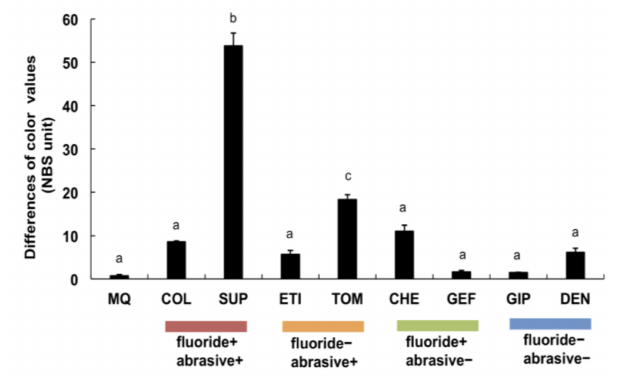
Figure 3. Influence of brushing with toothpastes or MQ on titanium color. The color values represent the variations with the values of control sample. Independent experiments were repeated three times. Data represent the means ± SD of triplicate experiments. The different letters among the samples indicate a statistically significant difference ( p < 0.05 or p < 0.01).